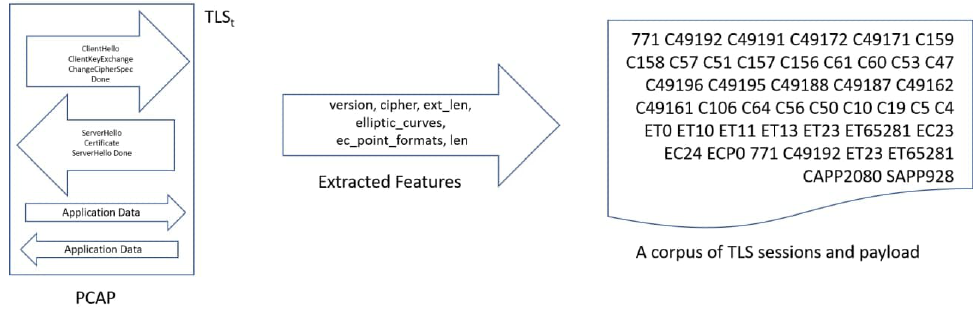
Figure 1. Overview of